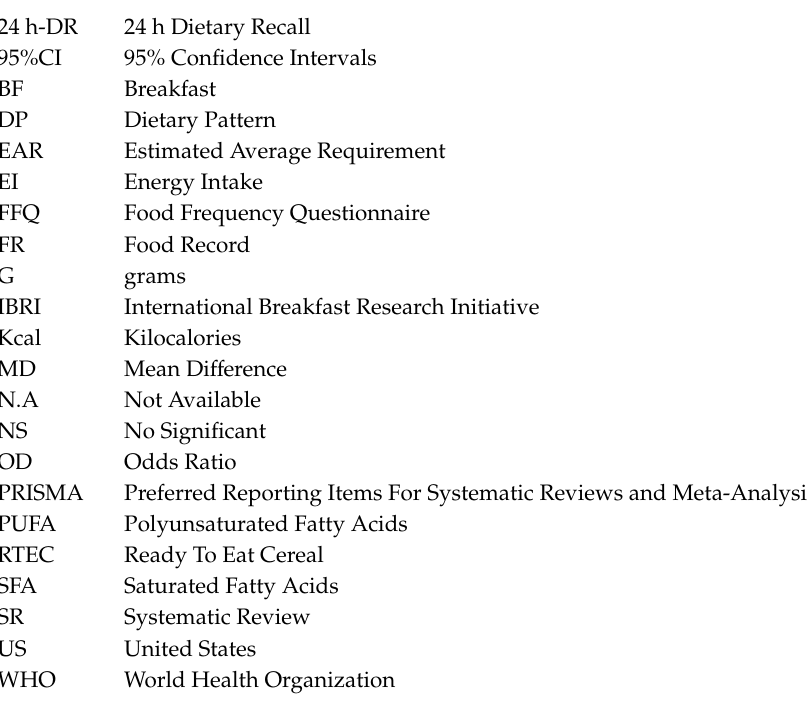
Table S1. Quality appraisal